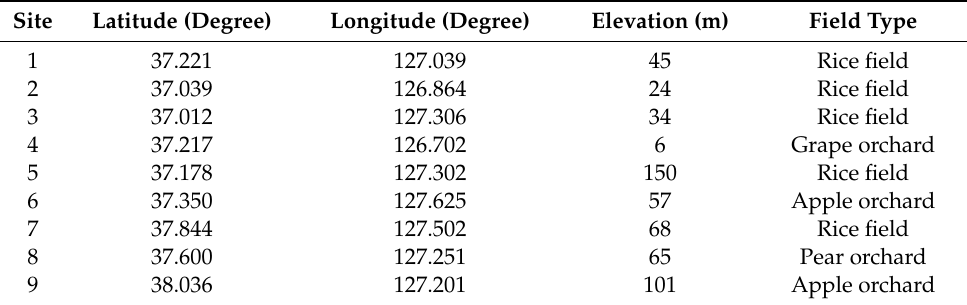
Table 1. Information regarding meteorological